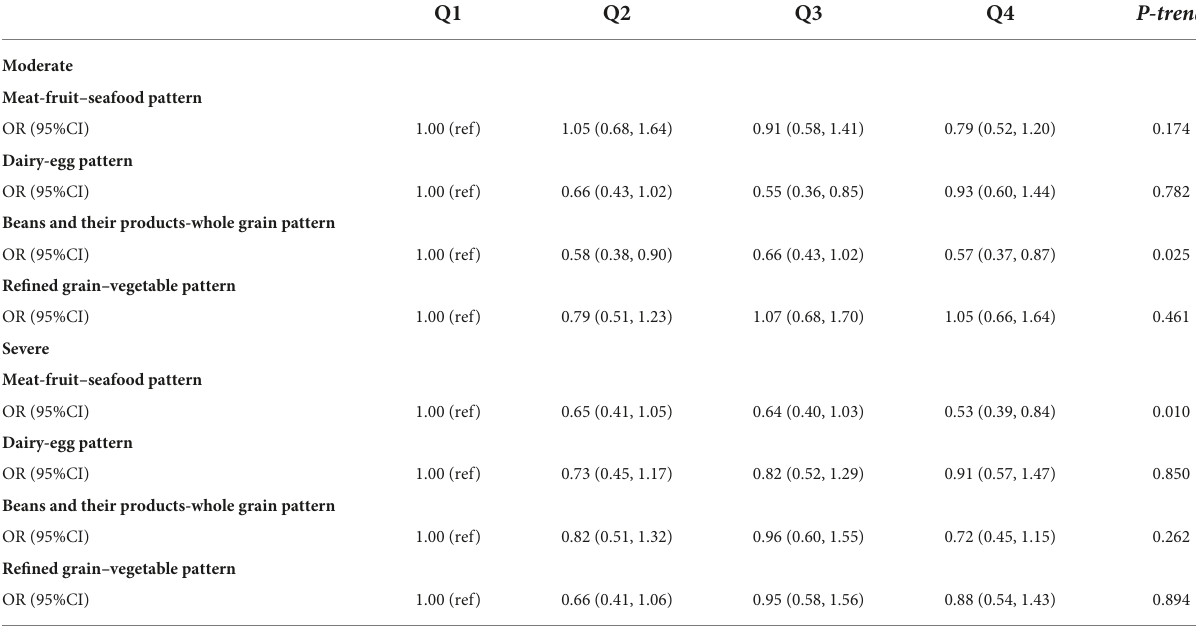
TABLE 3 Associations between dietary pattern score quartile and initial clinical manifestations. Q1 Q2 Q3 Q4